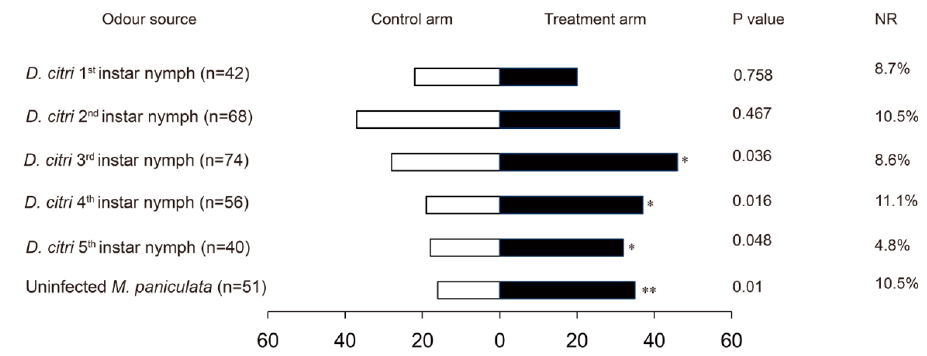
Figure 2. Response of male Tamarixia radiata to odours emitted from Diaphorina citri nymphs versus Figure 1. Response of female Tamarixia radiata to odours emitted from Murraya paniculata or blank controls with a Y-tube olfactormeter. NR: percentage of non-responders. Diaphorina citri nymphs versus blank controls, respectively, within a Y-tube olfactormeter. * indicates significant differences between the white bars and black bars (* P < 0.05, ** P < 0.01). NR: percentage of non-responders.